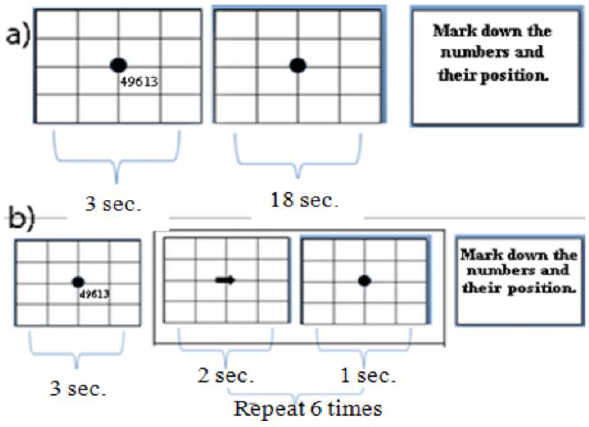
Figure 2. ( a ) The Low Spatial mental exercise ( b ) The High Spatial mental exercise Figure 2 . ( a ) The Low Spatial mental exercise ( b ) The High Spatial mental exercise [10].